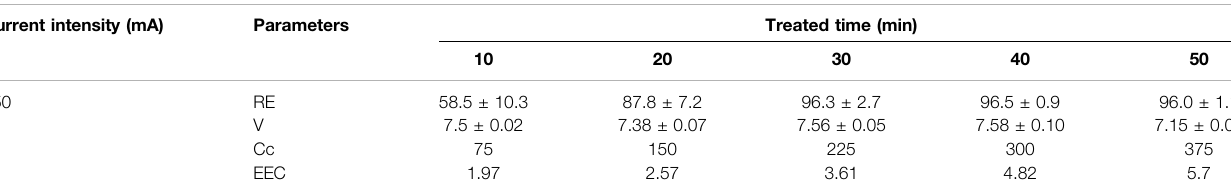
TABLE 1 | Performance of SBEF on harvesting N. oculata at 450 mA. Current intensity (mA)